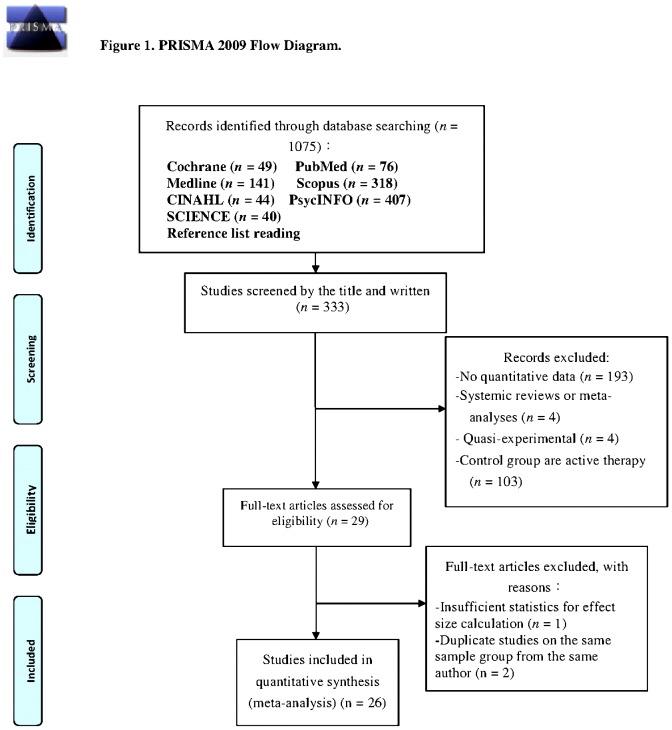
PRISMA 2009 flow diagram.